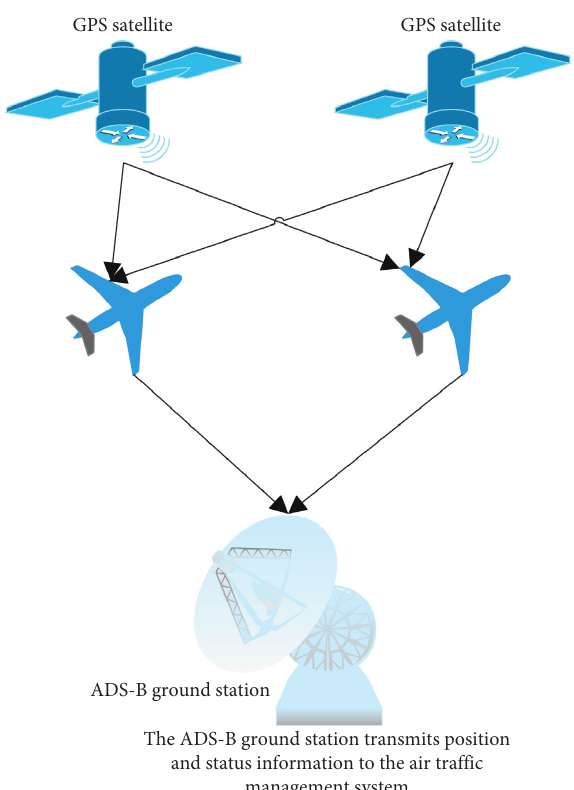
Figure 9: Schematic diagram of system